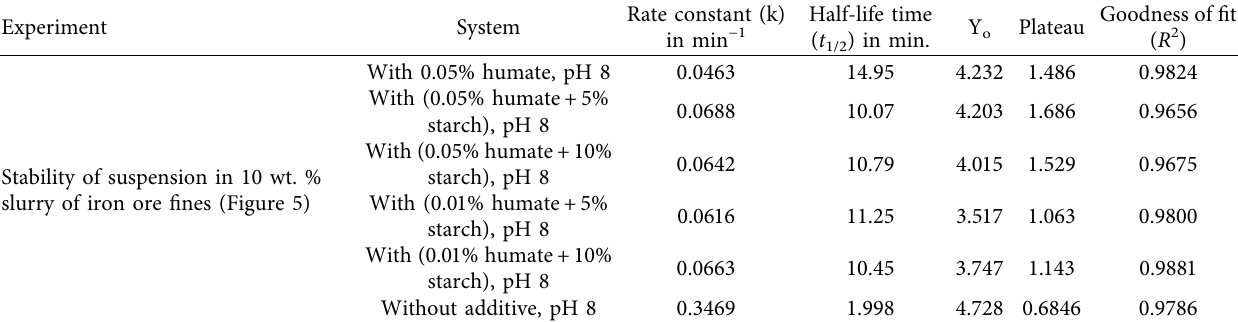
Stability of suspension in 10 wt. % slurry of iron ore fines (Figure 5)